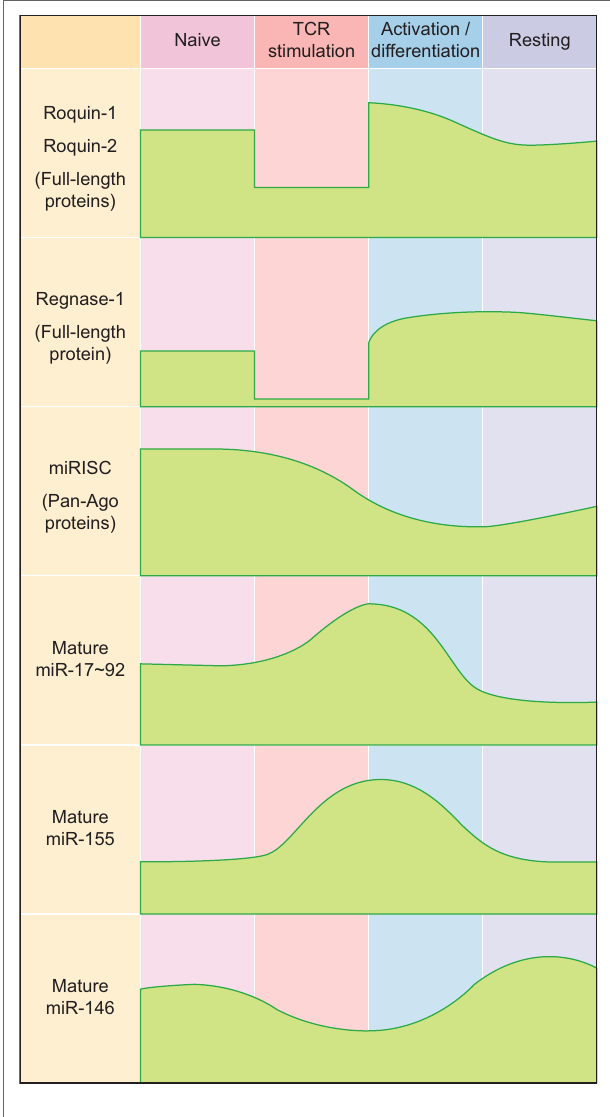
FiGURe 1 | Expression kinetics of major RNA-binding proteins and microRNAs (miRNAs) during T helper cell differentiation. Abbreviations: miRISC, miRNA-induced silencing complex; Ago,